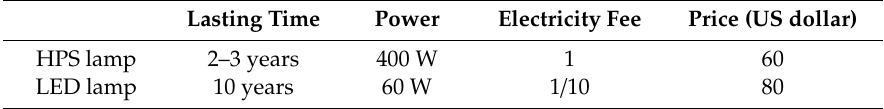
Table 1. Comparison between high-pressure sodium (HPS) and light emitting diode lamp. Table 1 . Comparison between high-pressure sodium (HPS) and light emitting diode lamp. Lasting Lasting Time